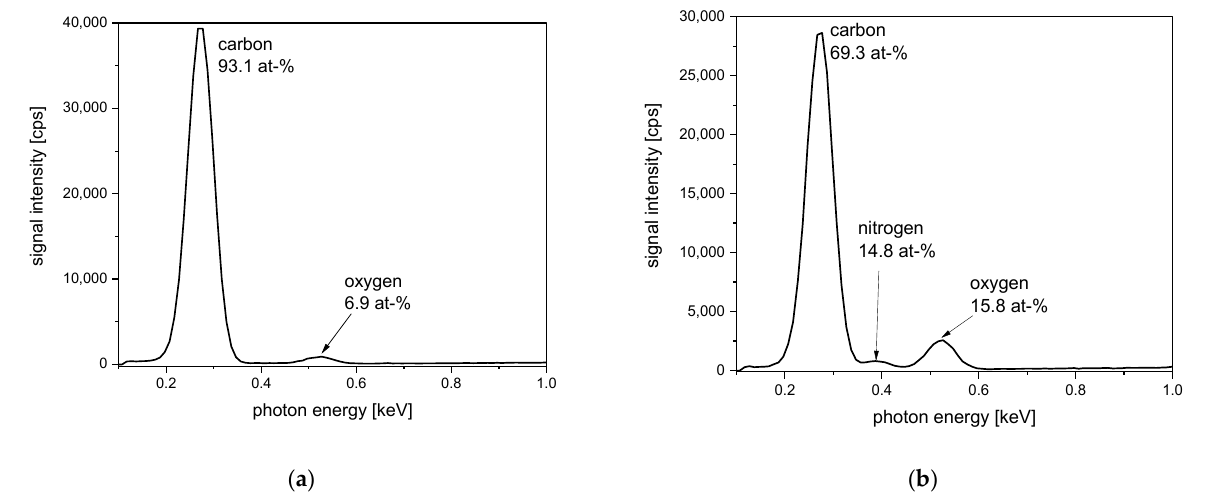
Figure 6. EDS spectra taken from a high-strength rope—( a ) HPPE fiber material (Dyneema) taken from the core of the rope; ( b ) PBO fiber material taken from the outer layer of the rope.